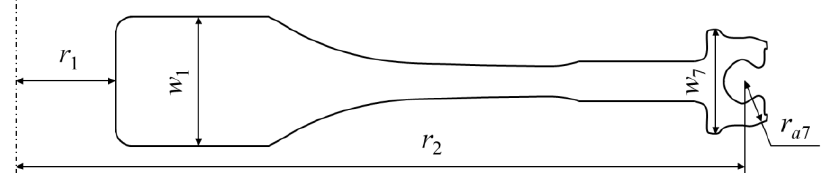
Figure 5. Parametric model of the compressor disk.